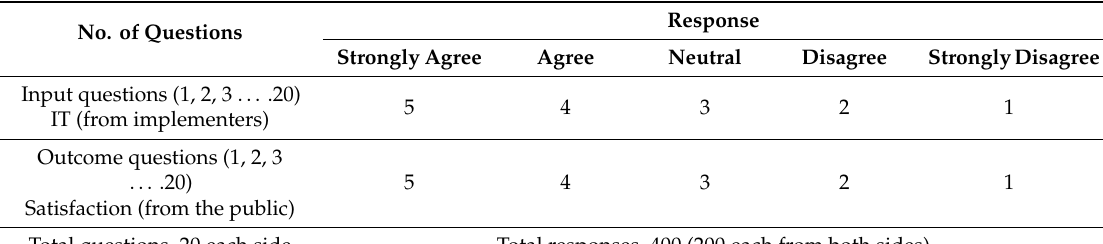
Table 1. Survey questionnaire